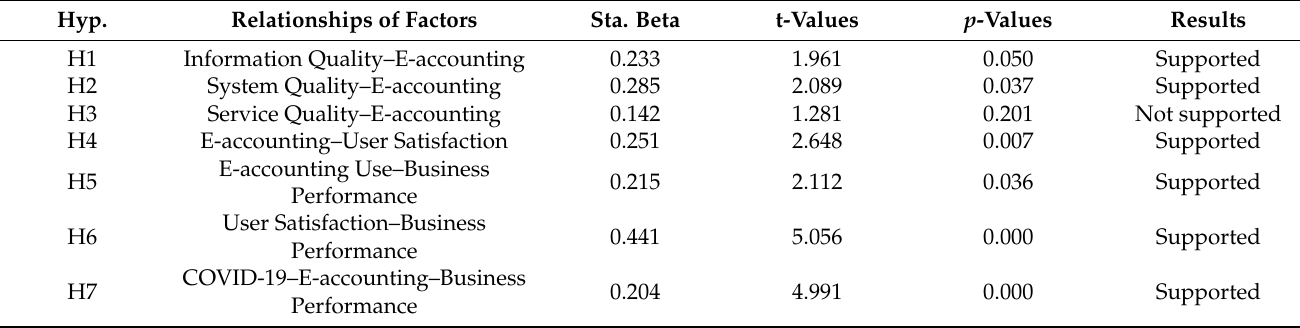
Table 3. Hypothesis testing of study